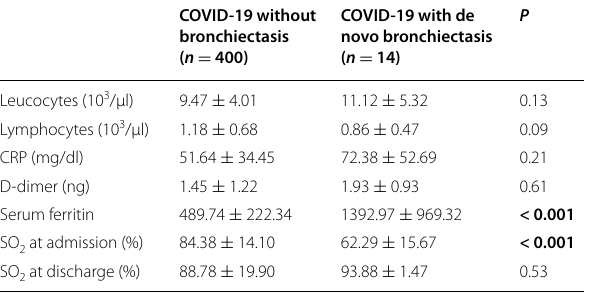
Table 2 Clinical characteristics of COVID-19 patients without and with de novo bronchiectasis included in the study